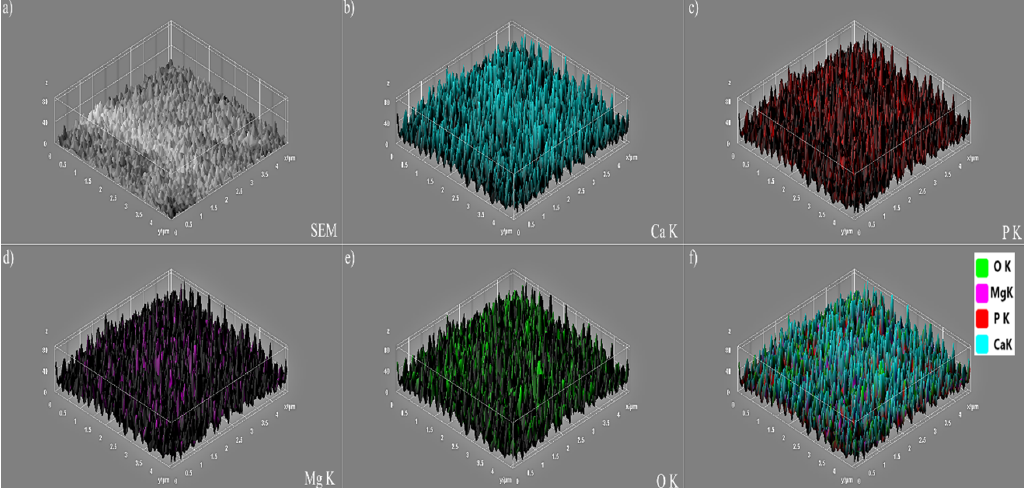
Figure 10. 3D representation of SEM image ( a ), mapping analysis of Ca ( b ), P ( c ), Mg ( d ), O ( e ), and superposition of all constituent elements ( f ) of the 25MgHAp coatings surface.